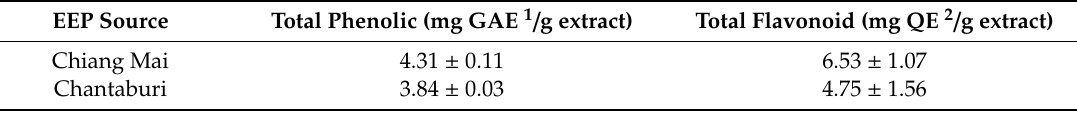
Table 1. Total phenolic and flavonoid contents of ethanolic extract of SLB propolis (EEP).